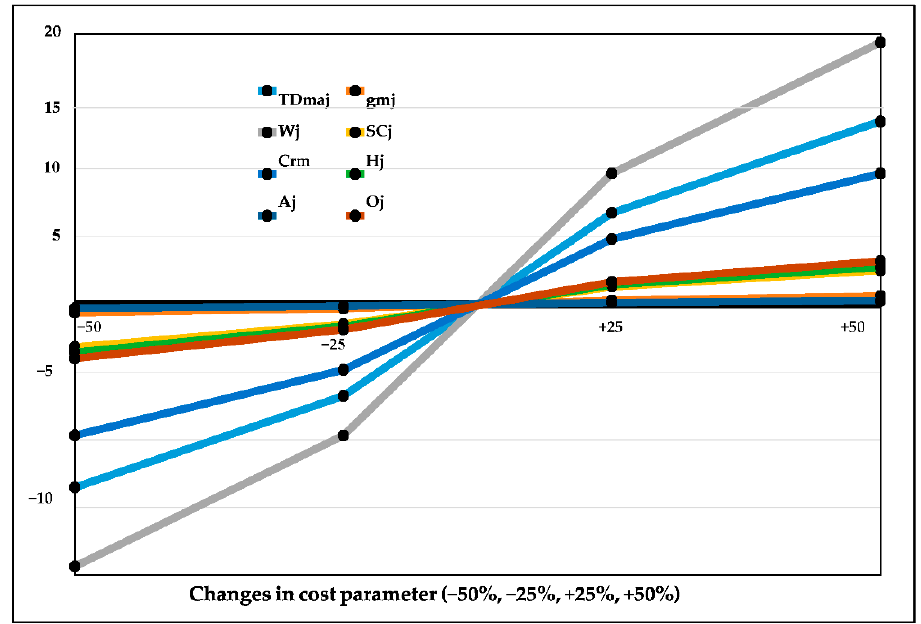
Figure 2. The sensitivity of total cost of Agri-SCM with respect to the cost parameters.